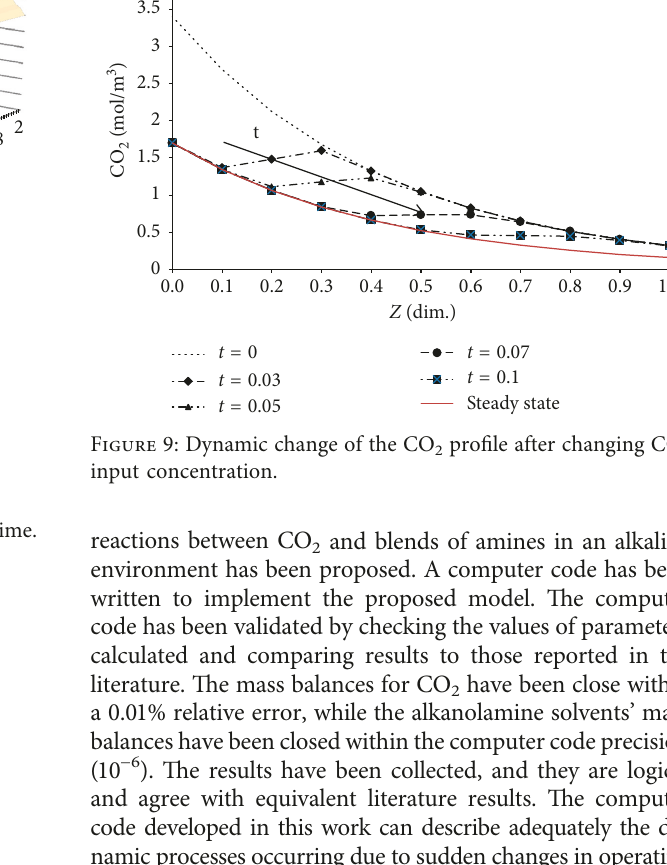
2 profile produced by dou-